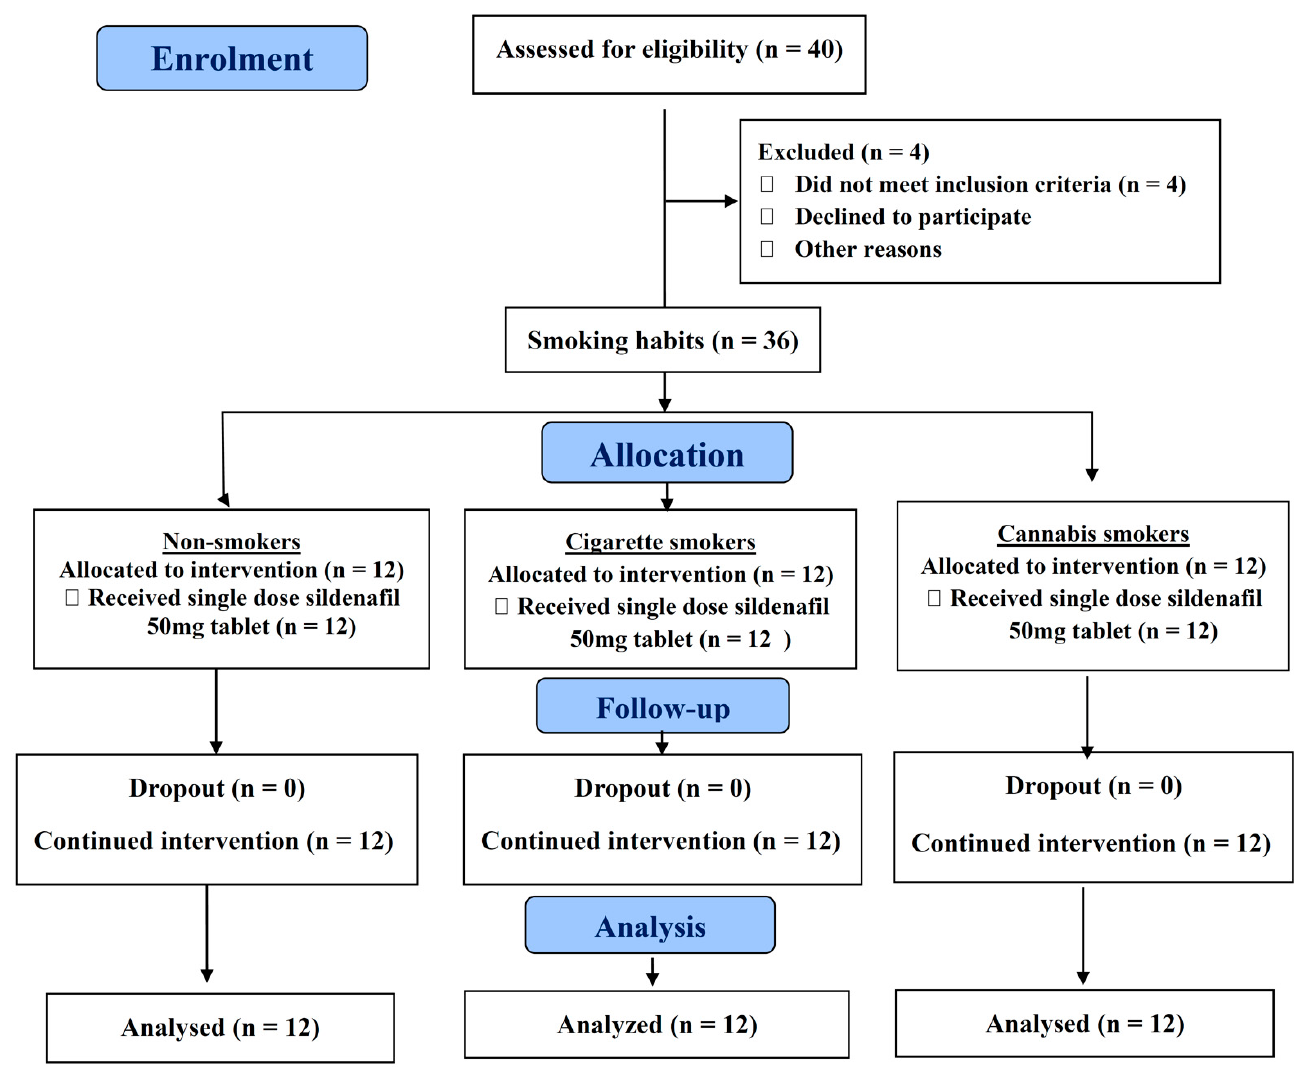
Figure 1. The study flow chart (consort diagram).